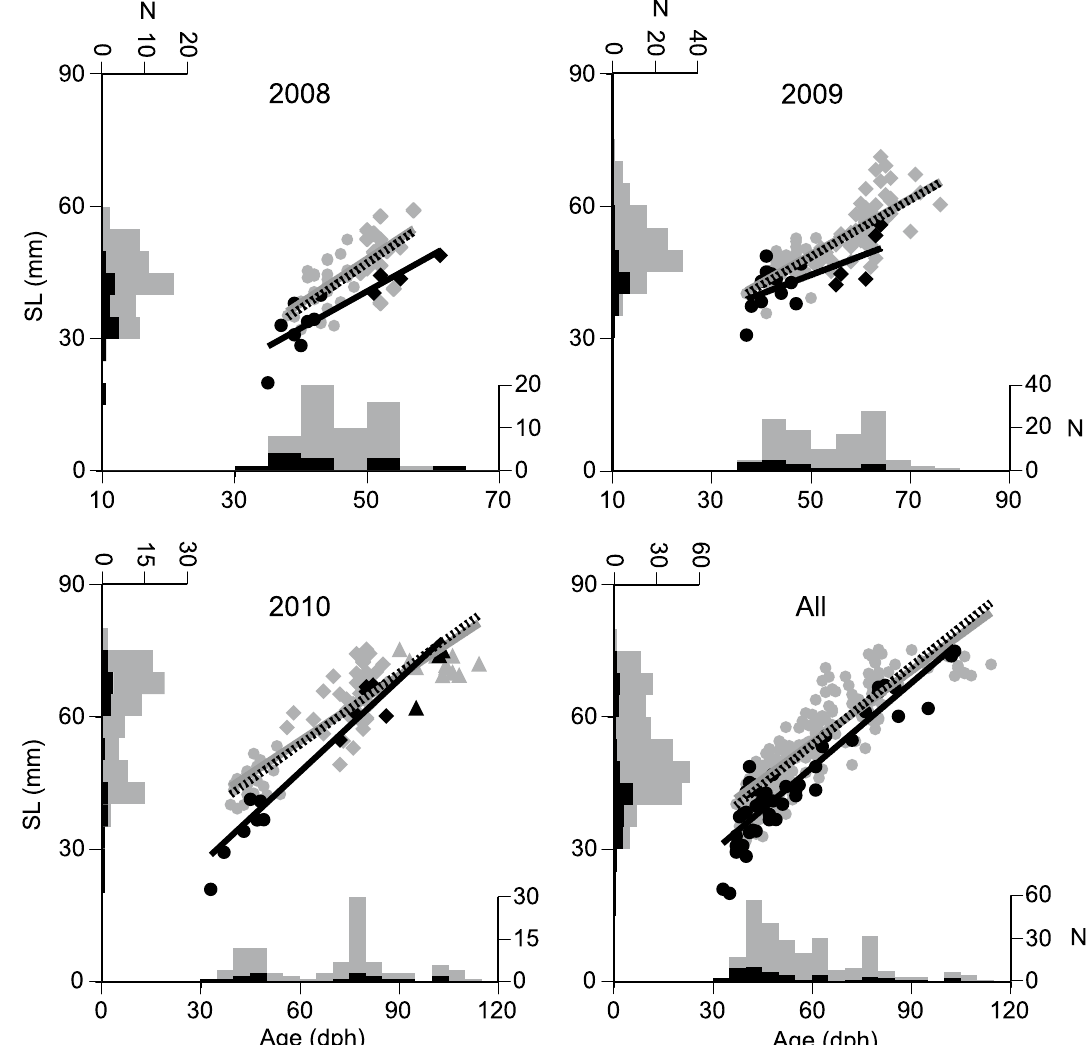
Figure 5. Relationships between standard length (SL) and age of the consumed (black) and netted (grey) juveniles of Trachurus japonicus across the study years and pooled years. The thick solid grey and black lines indicate linear regression lines of the netted and consumed juveniles, respectively. Dotted black lines indicate the age-SL relationship taking into consideration net bias for the netted juveniles. Frequency distributions for SL and age in each panel indicate the number of individuals in the 5 mm and 5 dph classes, respectively. Circles and diamonds in 2008 and 2009 indicate younger and older age cohorts based on the cluster analysis. In 2010, circles, diamonds, and triangles show younger, middle and older age